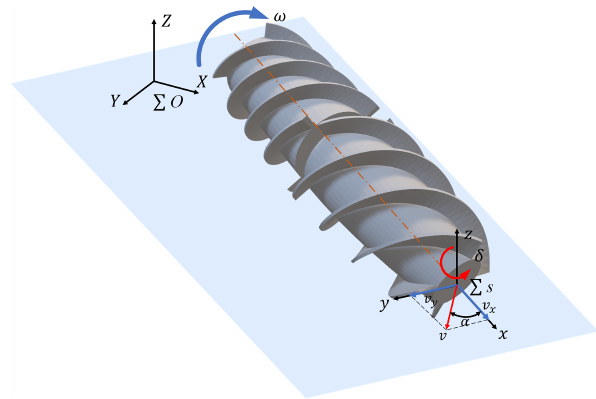
Figure 6. Kinematic model of the screw